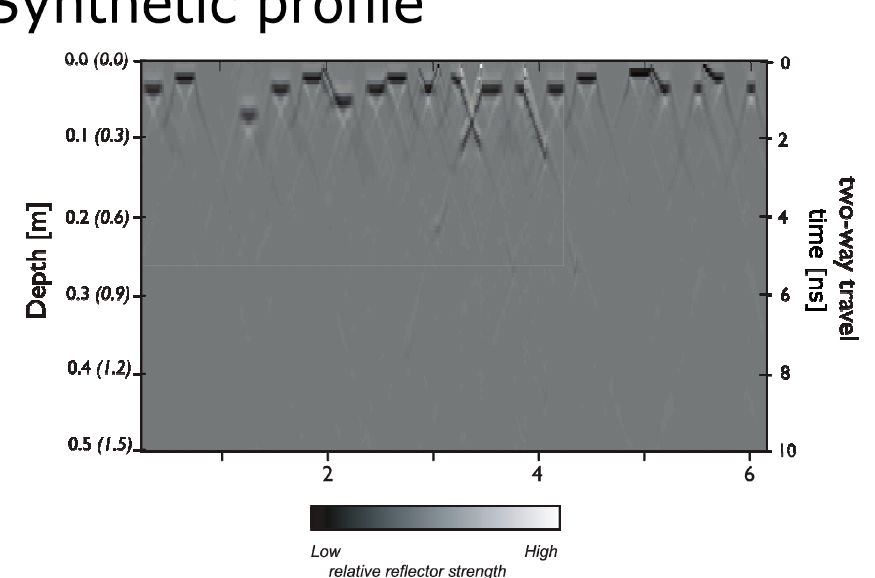
Figure 8. Physical model showing the synthetic GPR profile expected from a series of air-filled hoof depressions in the ground surface.